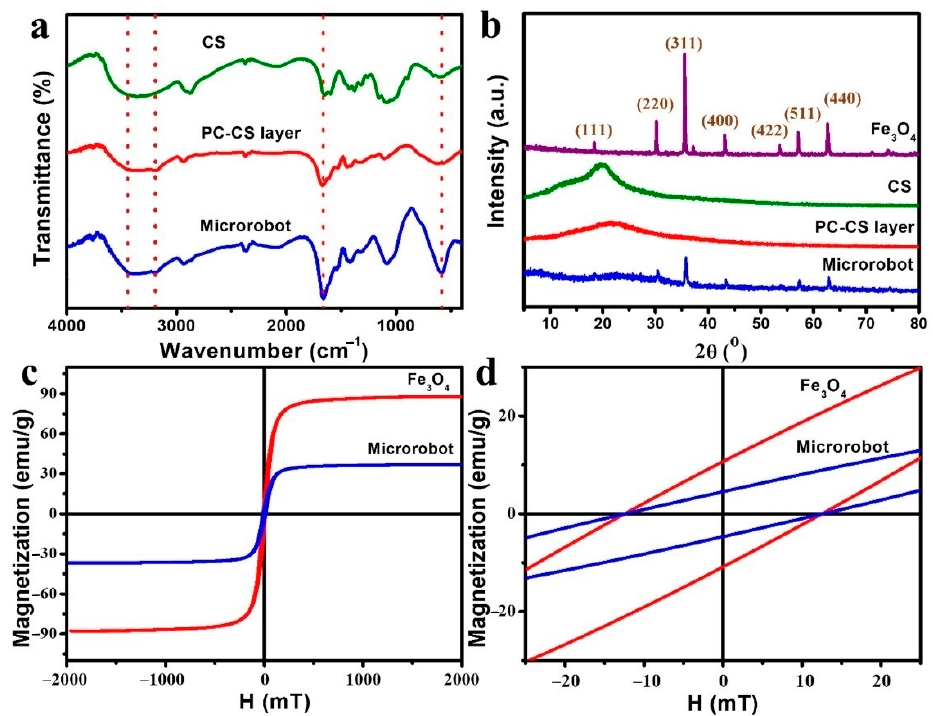
Figure 5. ( a ) FTIR spectra of pure chitosan, the top layer of the microrobots, and the microrobots. ( b ) XRD patterns of Fe 3 O 4 nanoparticles, chitosan, the top layer of the microrobots, and the micro- robots. ( c ) Magnetic hysteresis loops of Fe 3 O 4 nanoparticles and the microrobots. ( d ) Zoomed-in view where the hysteresis loops of the Fe 3 O 4 nanoparticles and the microrobots